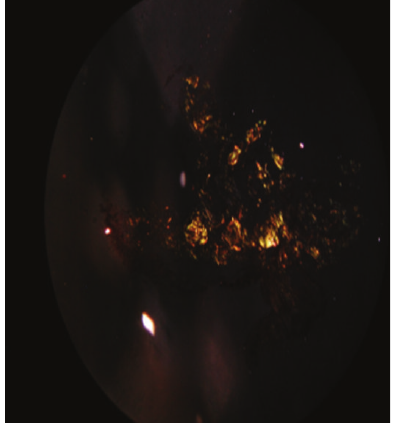
Figure 3: Transbronchial biopsy green birefringence under polar- ized